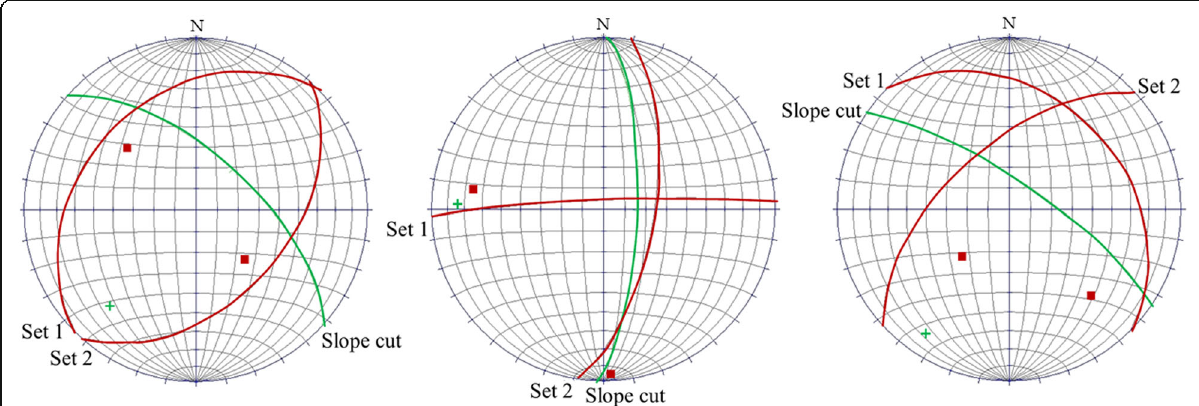
Fig. 6 The stereographic projections of ( a ) Station 7; b Station 13; and c Station 14. Set 1 and set 2 of the projected discontinuous planes in Station 7 show wedge failure type in both sets. In Station 13, set 1 shows toppling failure while set 2 shows planar failure type. Lastly, the types of planar and wedge failure were shown in set 1 and set 2, respectively, in Station 14 discontinuous plane in the slopes. The diagrams show that the dominant strike orientation of the discon- tinuous planes was trending northeast-southwest (N 60°E) in the andesite unit (Fig. 7a), northeast- southwest (N 45°E) in the crystalline limestone units (Fig. 7b), northwest-southeast (N 325°E) in the frag- mental limestone units (Fig. 7c), and northeast- southwest (N 40°E) in the reefal limestone units (Fig. 7d). In general, the most dominant strike orientation of all discontinuous planes in the study area was trending northeast-southwest (N 45°E). Table 15 Slopes and discontinuous planes orientations (strike/dip) and the failure types